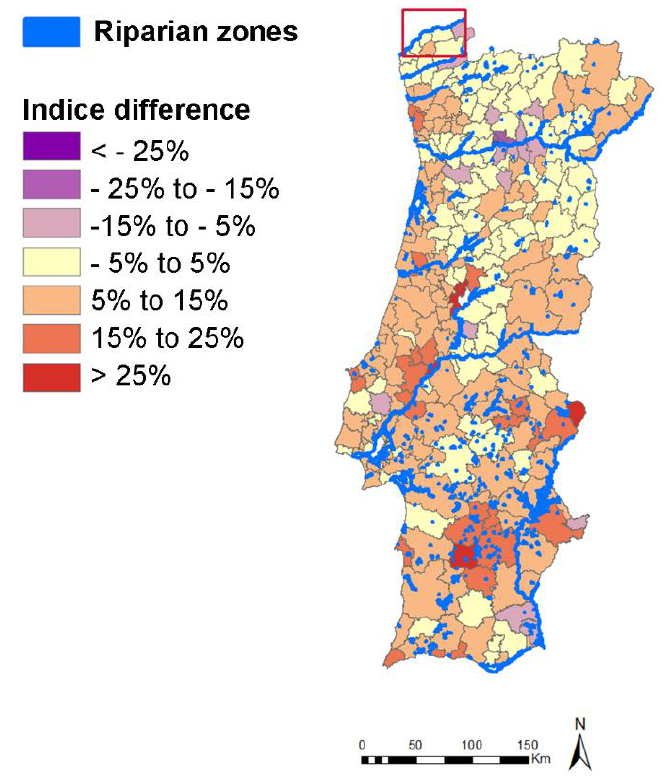
Figure 6. Difference between study results and Pollination Suitability Index for Riverine Landscapes (PSIRL) with riparian zone overlay. Red box indicates River Minho area, in north western Portugal.